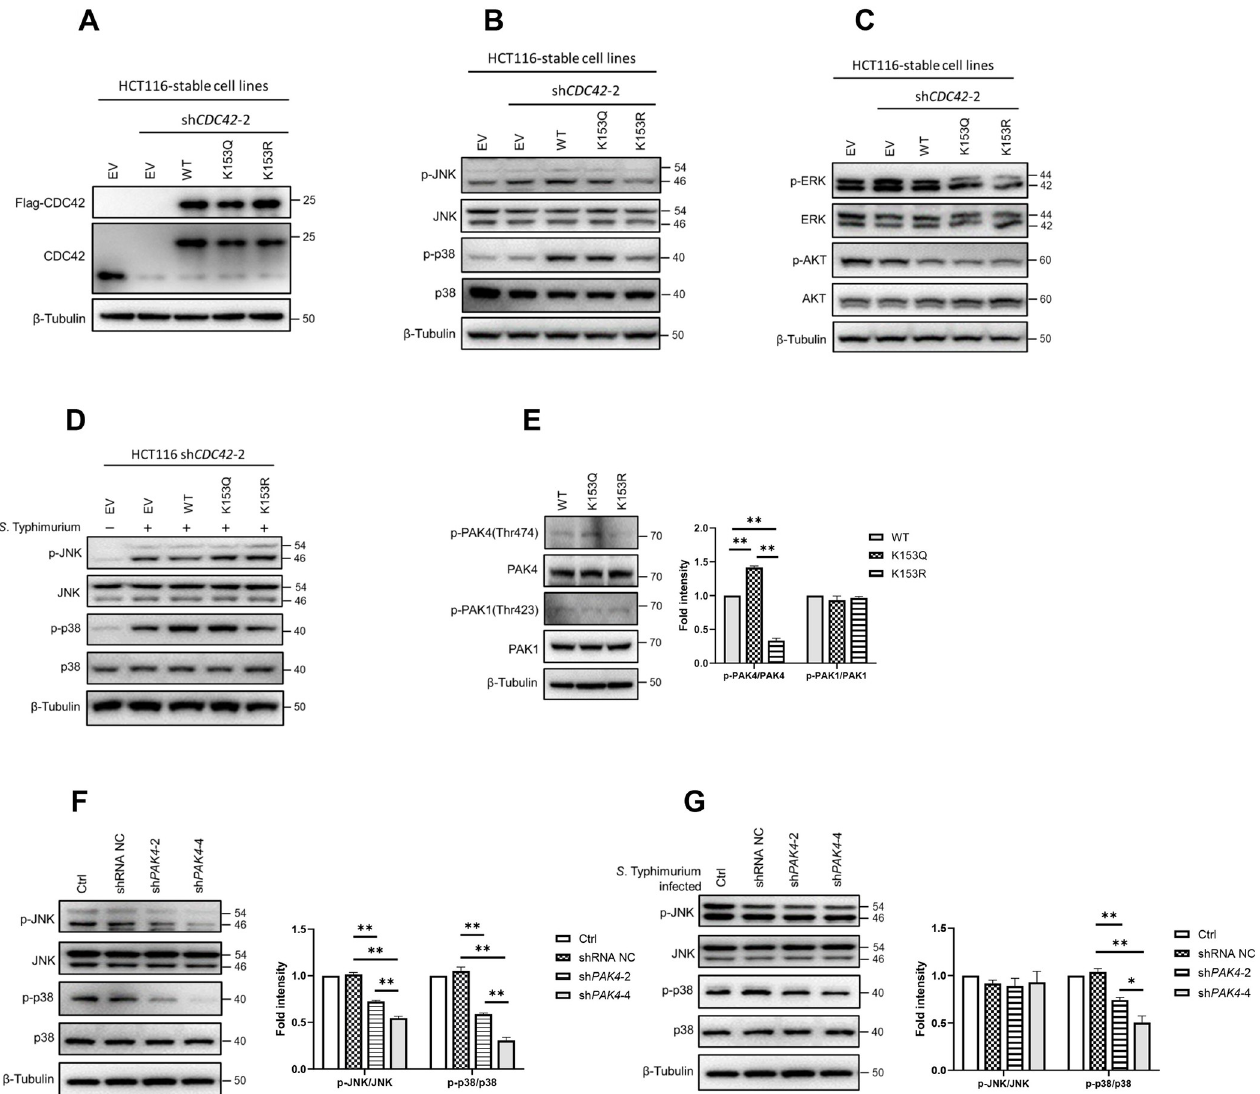
Fig 5. Acetylation of CDC42 K153 affects JNK and p38 phosphorylation. (A) HCT116 cells stably expressing Flag-CDC42-WT, Flag-CDC42 K153Q, or Flag-CDC42 were established. pCDH-flag vector (EV) was used as a control, and the cells were assessed by WB with anti-Flag antibody and anti-CDC42 antibodies. (B) Phosphorylation of JNK and p38 in K153R mutant. Phosphorylation of JNK and p38 were analyzed by WB in HCT116 cells stably expressing Flag-CDC42-WT, Flag-CDC42 K153Q, or Flag-CDC42 K153R, with pCDH-Flag vector (EV)-expressing cells as a control. (C) Determination of p44/42 (ERK) and AKT phosphorylation by WB in HCT116 cells stably expressing Flag-CDC42-WT, Flag-CDC42 K153Q, or Flag-CDC42 K153R, with pCDH-Flag vector (EV)-expressing cells as a control. (D) The phosphorylation of JNK and p38 were analyzed by WB in HCT116 cells stably expressing Flag-CDC42-WT, Flag- CDC42 K153Q, or Flag-CDC42 K153R treated by S . Typhimurium for 1 h. (E) Phosphorylation of PAK1 and PAK4 were determined in HCT116 cells stably expressing CDC42-WT, CDC42 K153Q or CDC42 K153R by WB (Left), and densitometry analysis was shown (Right). Phosphorylation levels of JNK and p38 were decreased in PAK4 knockdown cells, and a lower phosphorylation level of p38 in PAK4 knockdown cells after Salmonella infection. HCT116 cells with PAK4 knocked down were infected without (F) or with (G) S . Typhimurium for 1 h, and wild-type HCT116 cells was used as a control. JNK and p38 phosphorylation were analyzed by WB (Left), and densitometry analysis was shown (Right). � p < 0.05, �� p < 0.01. https://doi.org/10.1371/journal.ppat.1011189.g005 kinetics of PS externalization in HCT116 cells expressing CDC42 WT, CDC42 K153Q, or CDC42 K153R were determined by flow cytometry using Annexin V (AV) and propidium iodide (PI). The number of AV+PI- cells (21.96% ± 0.51%) in the K153R group was signifi- cantly less than those in the K153Q group, and the number of AV+ cells (30.49% ± 0.42%)